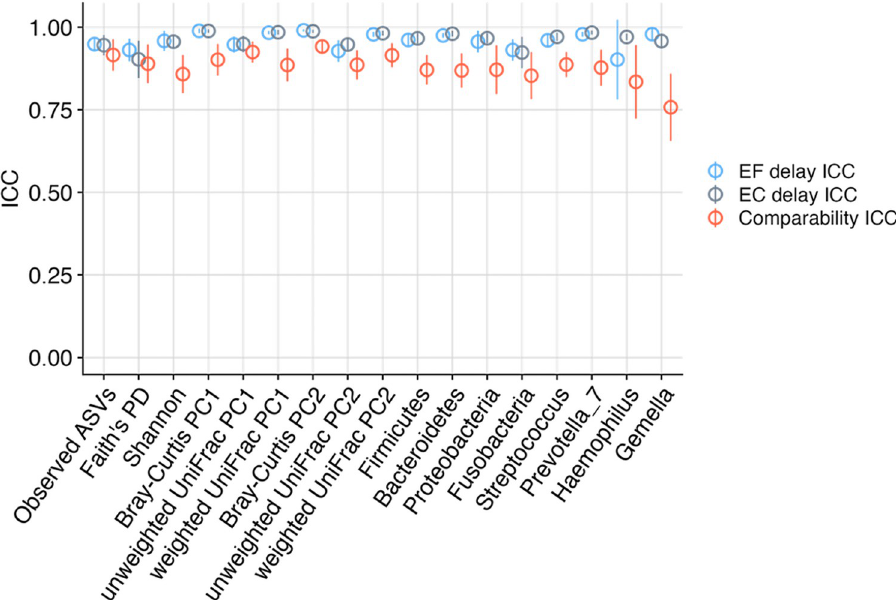
Fig 3. Intraclass correlation coefficients (ICCs) calculated for alpha and beta diversity metrics and the relative abundances of the top four abundant phyla and genera to assess the comparability of ethanol-free (EF)